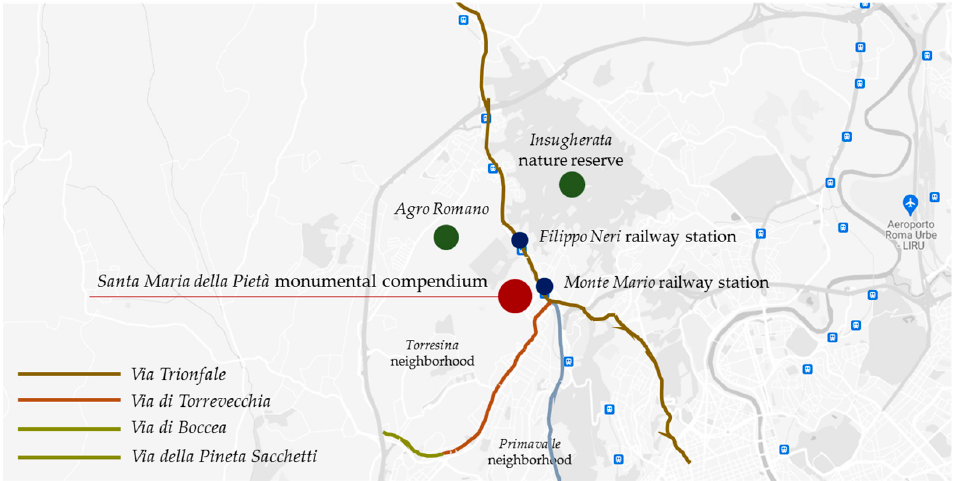
Figure 4. Santa Maria della Pietà monumental compendium, surrounding residential neighborhoods and main road axes.